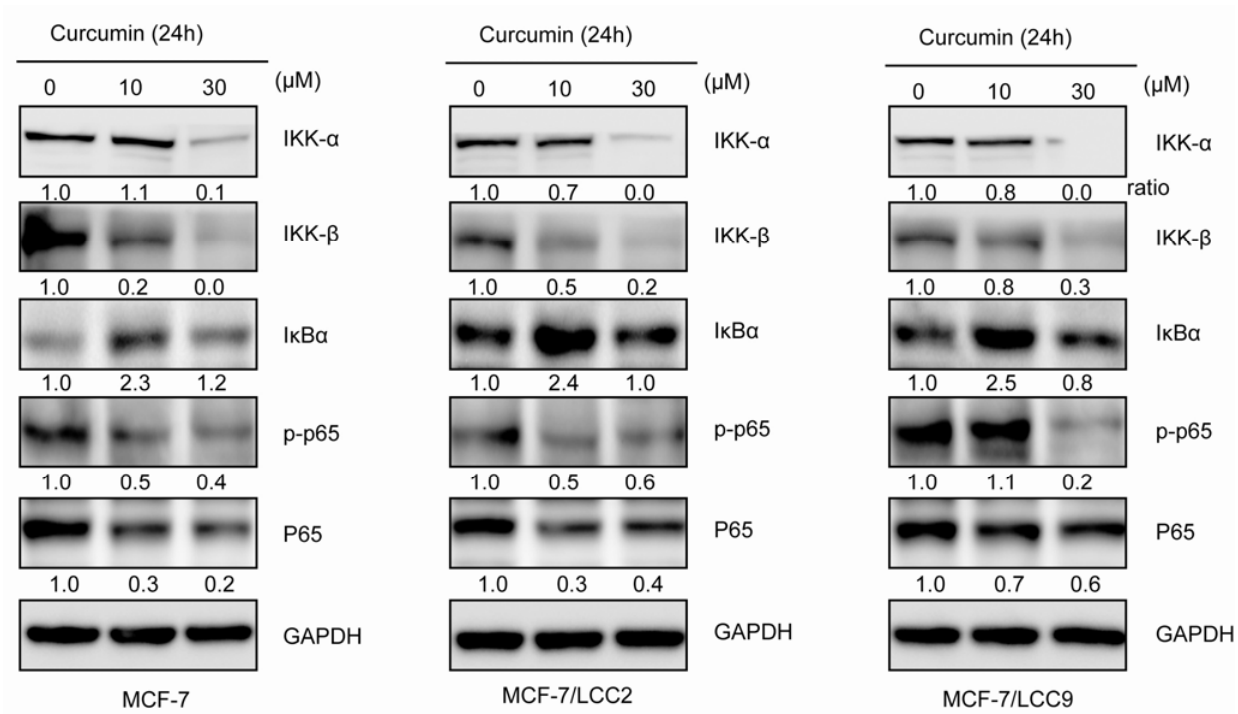
Figure 7. Curcumin inhibits IKK-NF- κ B signaling pathway in MCF-7/LCC2 and MCF-7/LCC9. Cells were incubated with curcumin (10 and 30 μ M) for 24h and then analyzed by western blot for IKK α , IKK β , I κ B α , p65 and p-p65